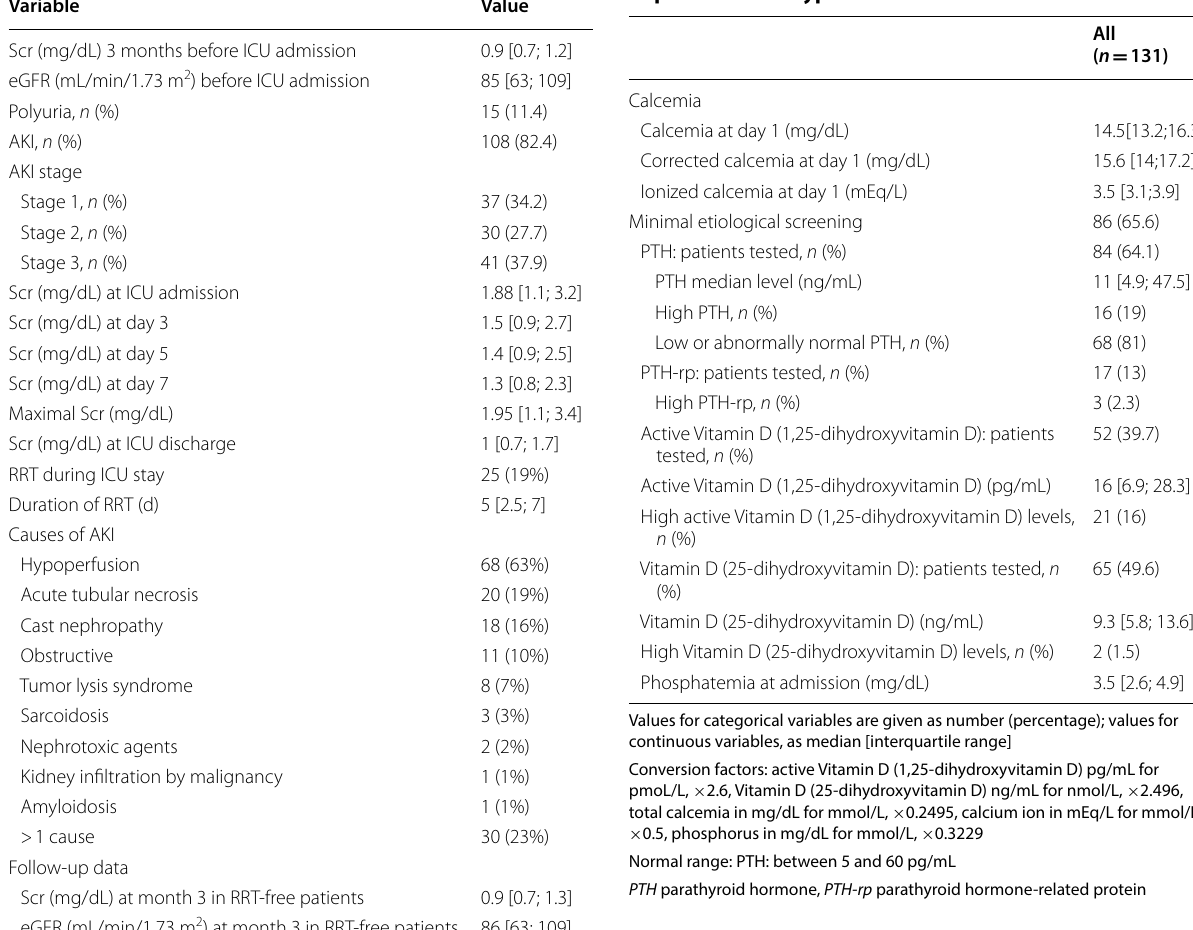
Table 2 Characteristics of AKI Table 3 Calcemia course and etiological